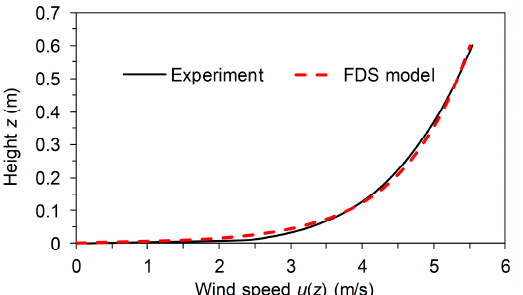
Figure 12. Comparison between the wind profiles of the experiment [37] and the FDS model.